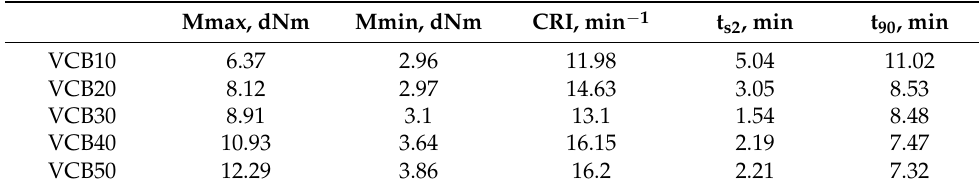
Table 5. Rheological data for all rubber